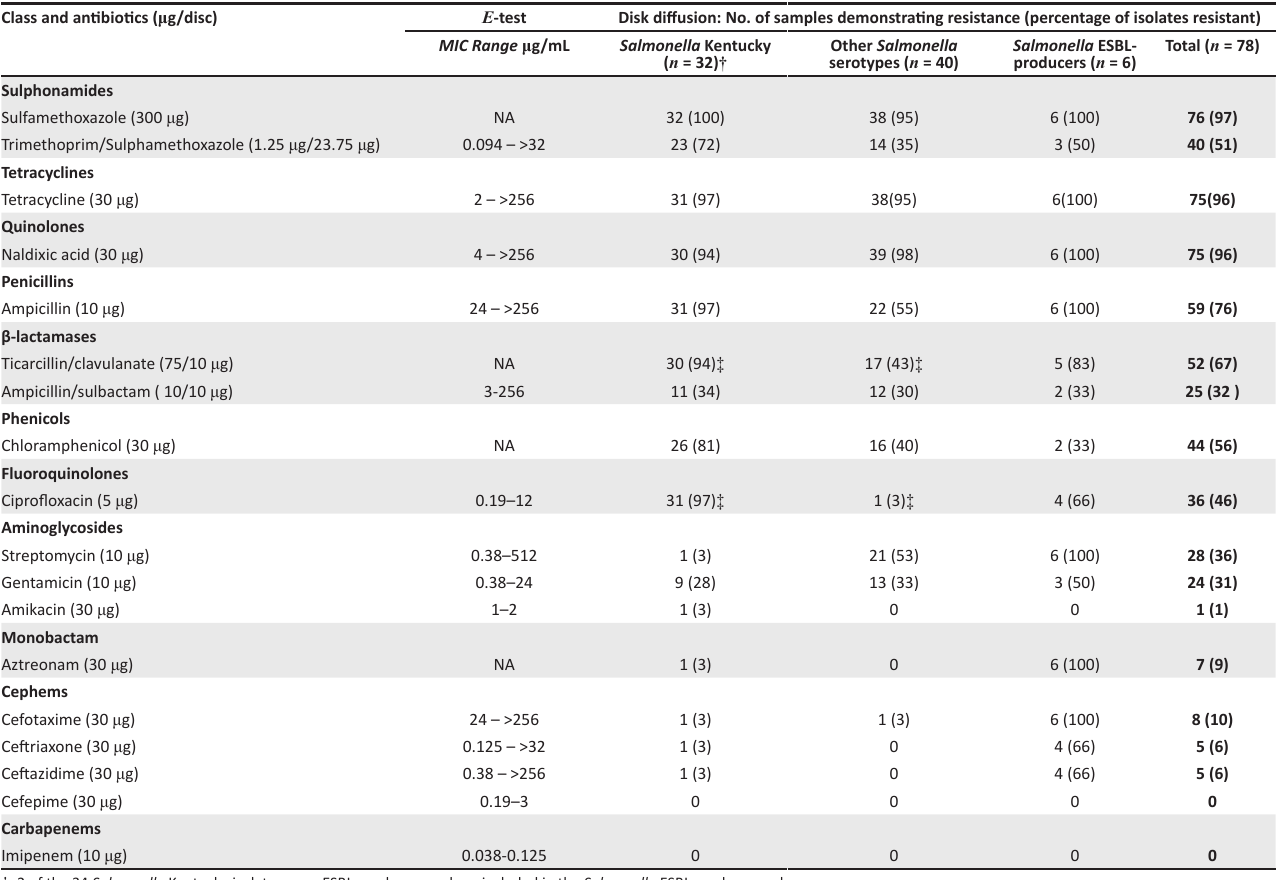
TABLE 3: Percent antibiotic resistance and MIC range of S. Kentucky, other Salmonella serotypes and ESBL-producing Salmonella isolates from poultry meat and faecal samples. Class and antibiotics ( μ g/disc)